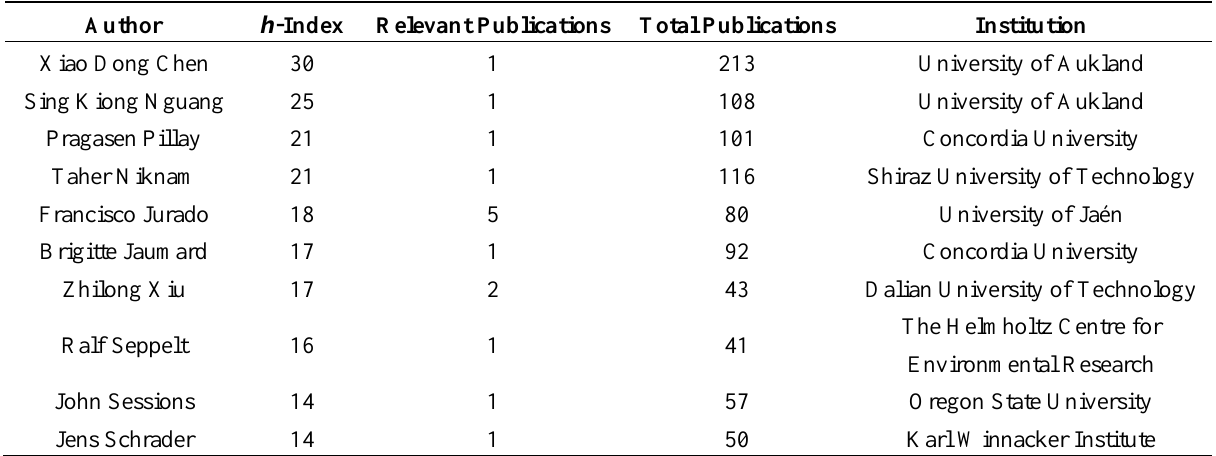
Table 5. Top ten scholars’